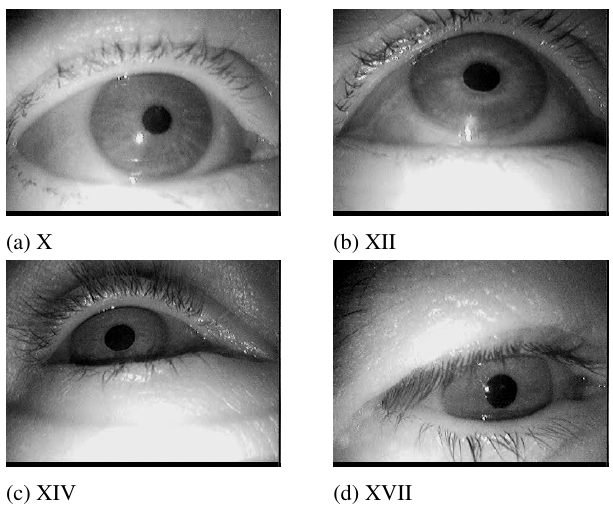
Figure 4 . Example images selected from the respective data sets published by Fuhl et al. (2015).